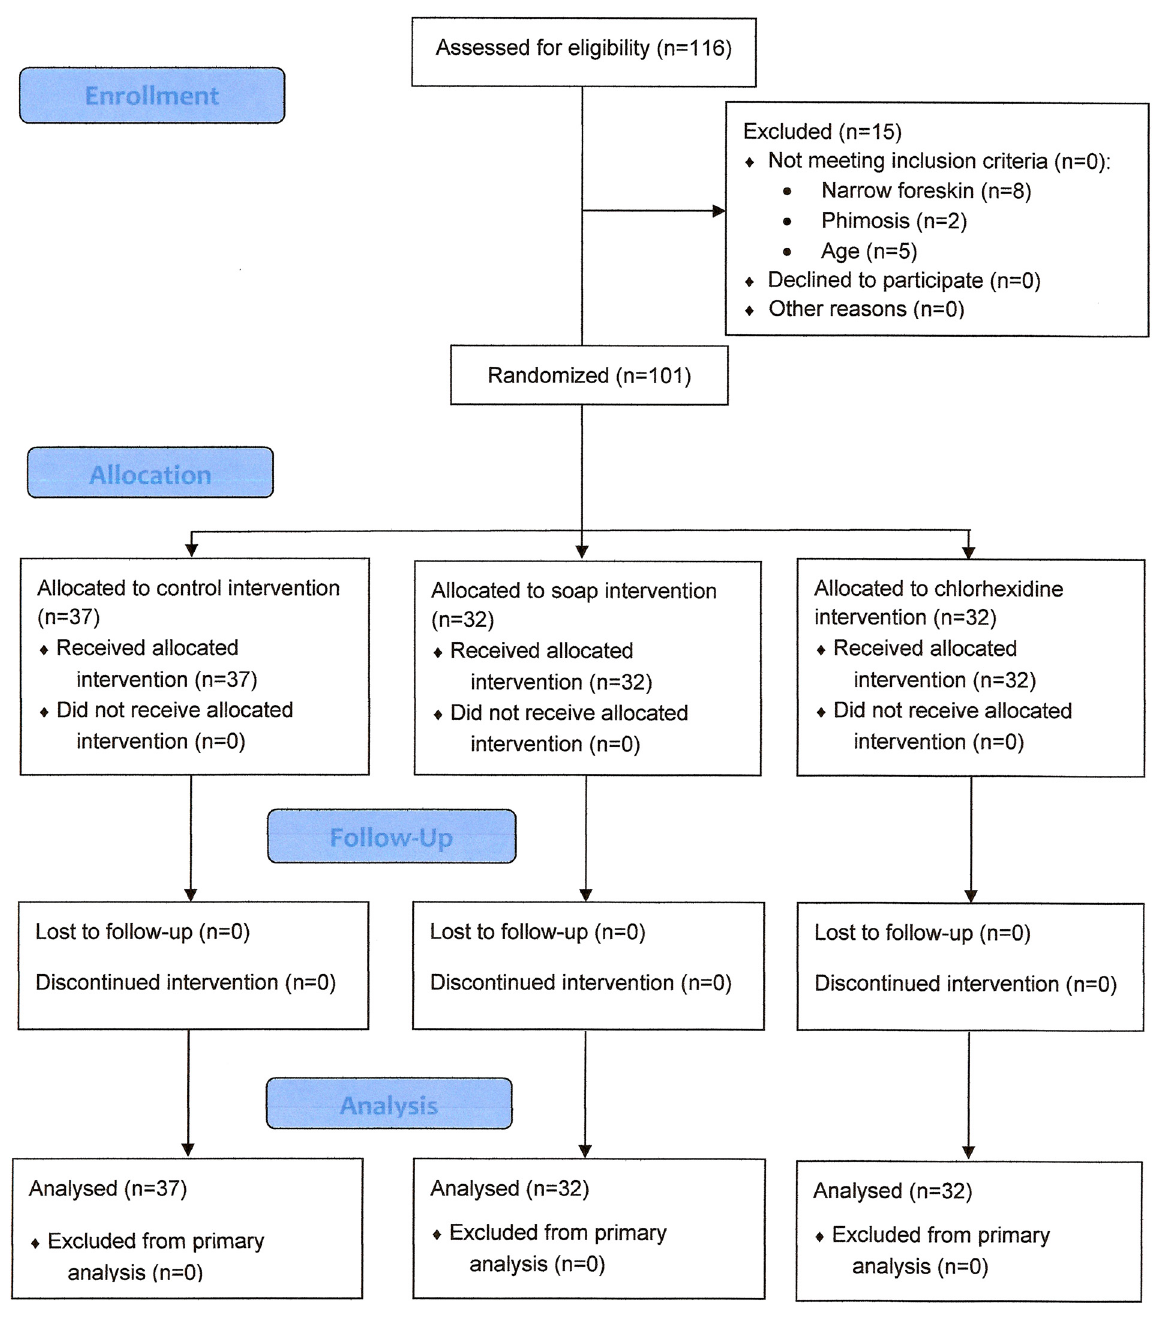
Fig 2. Flow of participants in the